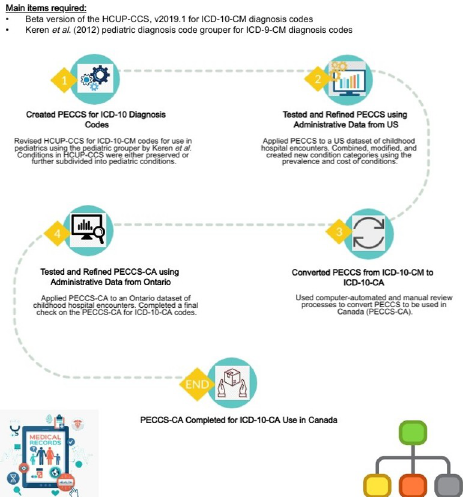
Fig 1. Overview of the steps used to develop the original PECCS, the translation process to develop PECCS-CA, and its’ application on administrative data of hospital encounters. This figure presents an overview of the steps our research team used to develop PECCS, translate PECCS from ICD-10-CM to ICD-10-CA to be used in Canada (PECCS-CA), and its’ application on administrative data of hospital encounters in Ontario. The references for the clip art pictures are presented below: 1) Clipart Library. (n.d.). Source: https://tinyurl.com/y69r2vm7; 2) PinClipart. (2018). Source: https://tinyurl.com/yxmdrv65; 3) Shutterstock. (2020). Source: https://tinyurl.com/y6a6qd29; 4) Tom Hand. (2019). Source: https://tinyurl.com/yyr2495o; 5) Convert Png To Icon. (2019). Source: https://tinyurl.com/y58snznv; 6) Pngitem. (2019). Source: https://tinyurl.com/y4hq8wa7; 7) SVG Repo. (n.d.). Source: https://tinyurl.com/yyvn6ons.